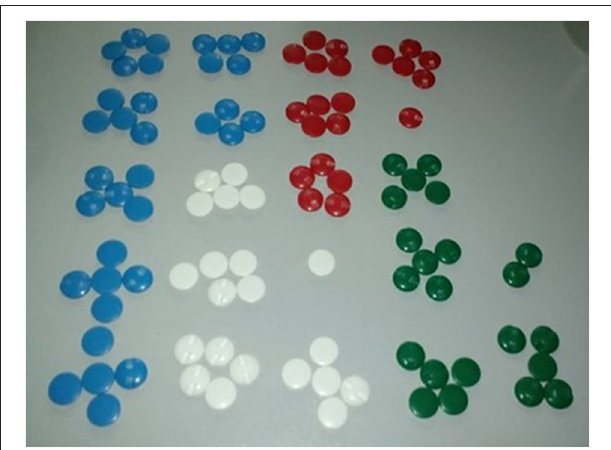
FIGURE 1 | Example of buttons being counted following interviews. Green buttons represented use of local wildlife; white buttons indicated pangolin consumption; red buttons indicated pangolin hunting. Blue buttons represented “no”